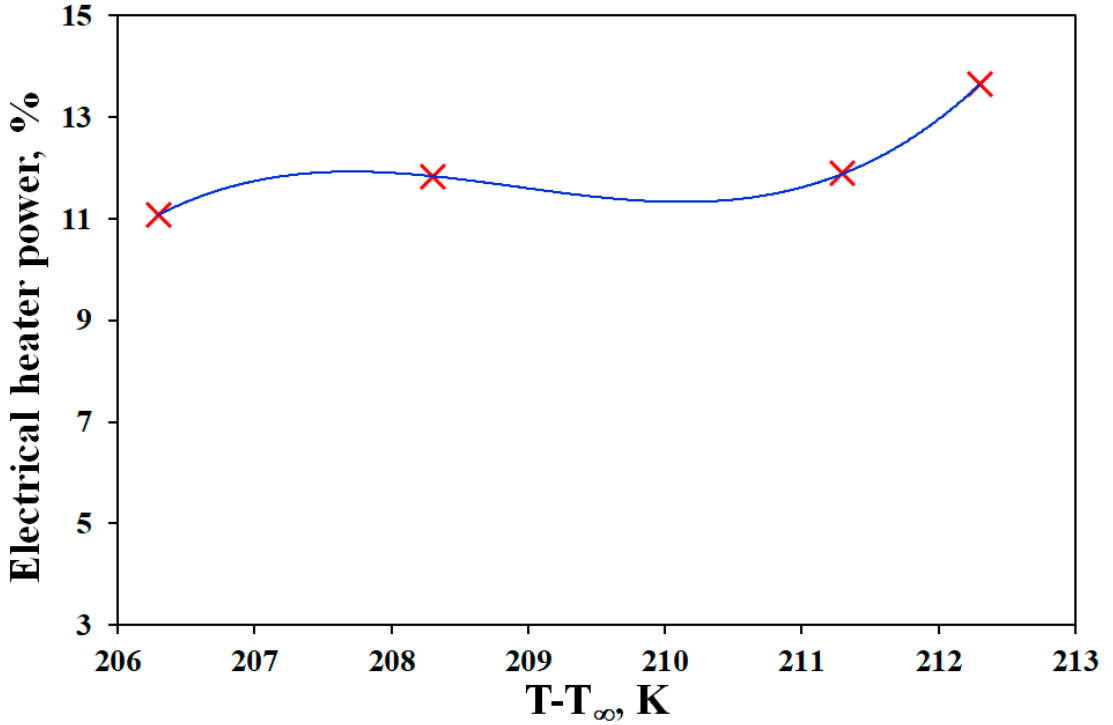
Figure 4. Fitted data for the power of electrical heater × as a function of difference between reactor and ambient temperatures; (×) experimental data and ( ▬▬ ) fitted curve.